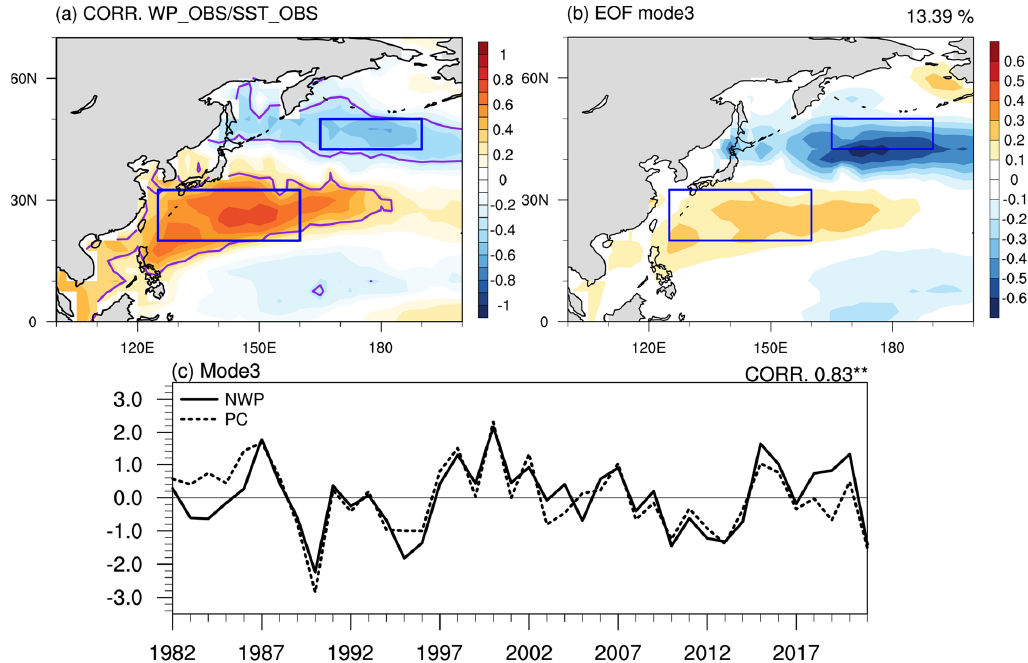
Figure 7. ( a ) The correlation pattern between SST and the WP index. Significant at the 95% confidence level values are enclosed by a thick line, and blue boxes enclose the areas of SST averaging used for the estimation of the NWP index; ( b ) the third EOF of the north-western Pacific SST anomalies. ( c ) The time series of the corresponding NWP index (solid line) and the PC3 (dashed line). Significance at the 99% (95%) level is denoted by a double (single) asterisk.